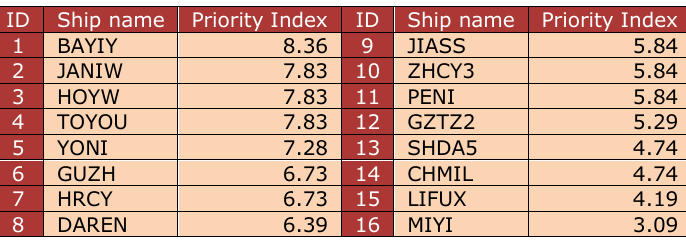
Table 10. Priority of Ship using